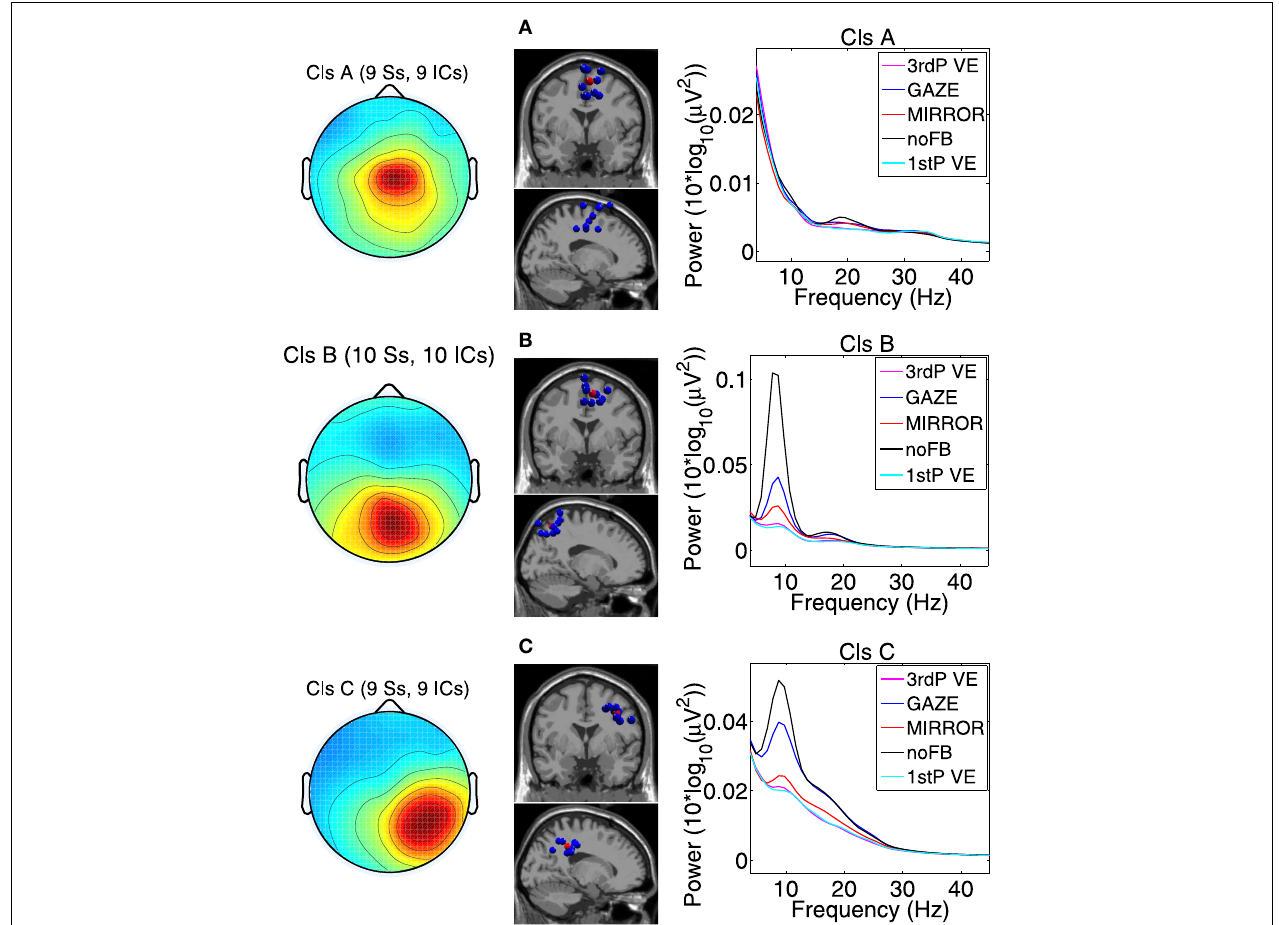
FIGURE 3 | Scalp projection, spatial location and power spectra of independent component clusters (A) Cluster A located in the supplementary motor area (premotor cortex); (B) Cluster B located in the posterior cortex (Brodmann area 7); (C) Cluster C located in the posterior cortex (Brodmann area 40). From left to right in each row: cluster average scalp projections; dipole locations of cluster ICs (blue